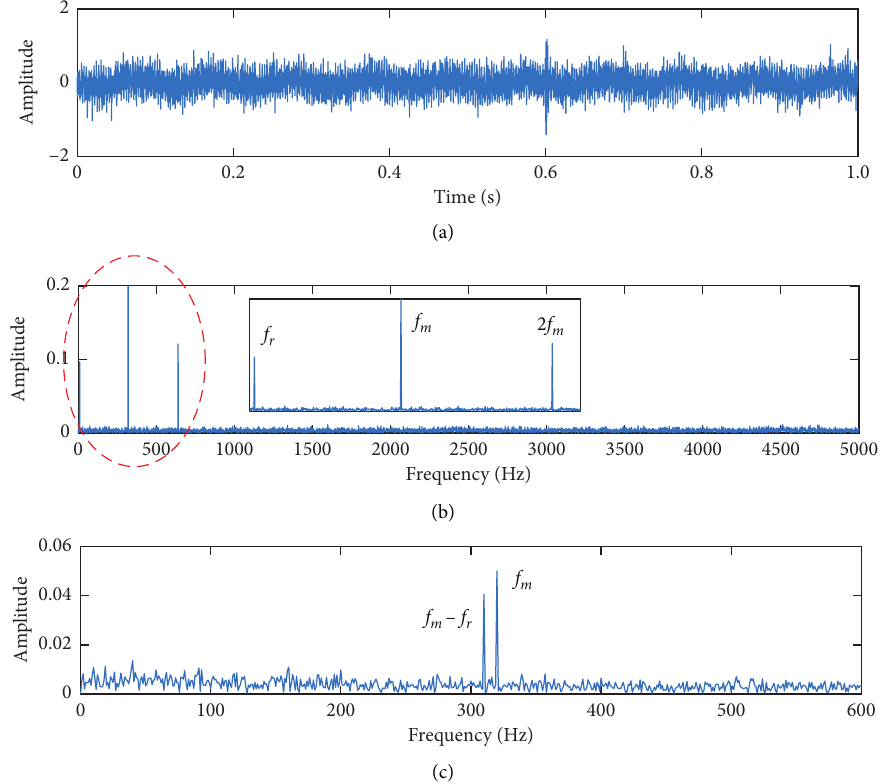
Figure 4: Simulated signals of case 1: (a) time-domain waveform, (b) frequency spectrum, and (c) squared envelope